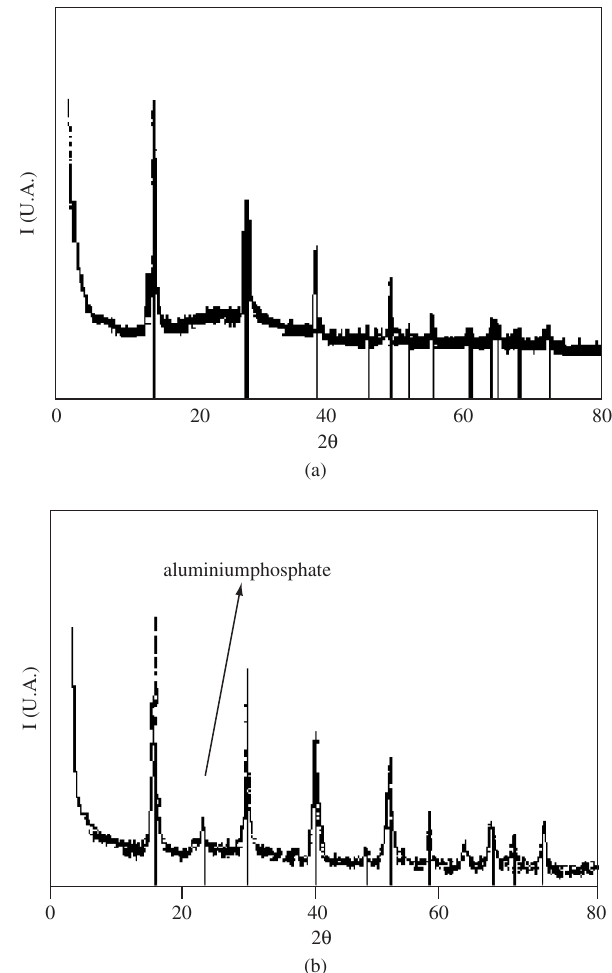
Figure 1. X ray diffraction patterns of Al and b)